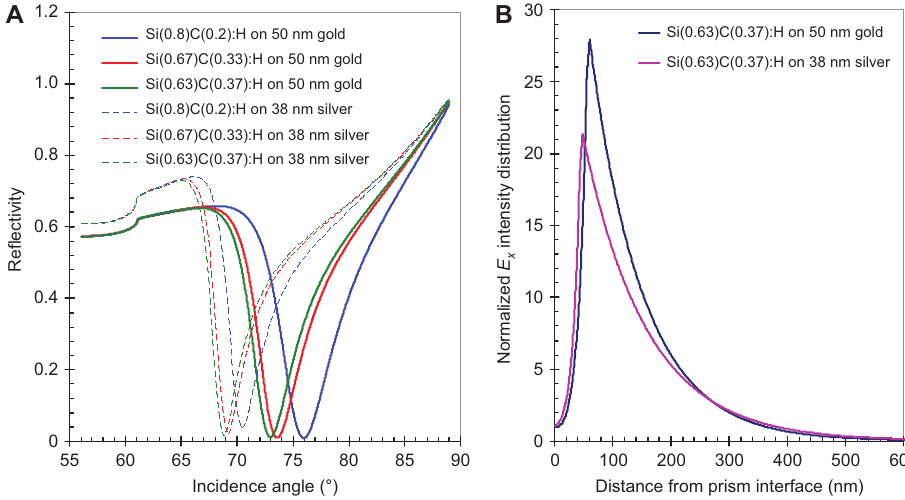
Figure 12 (A) Infl uence of carbon content of a 5 nm-thick a -Si tion vs. distance from prism interface for both 50 nm gold and 38 nm silver fi lms when it is coated with 5 nm a- Si = 1.52, λ = 670 nm, n used for calculations: n prism C :H) = 2.51 + n(Si 0.80 0.20